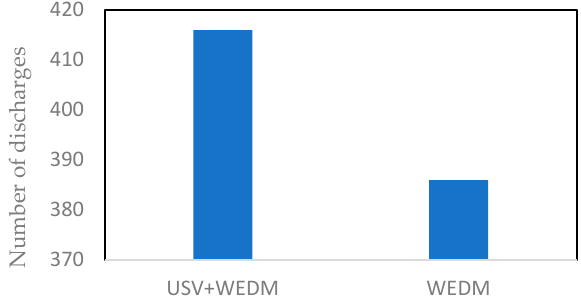
Figure 12 . Discharge waveform for ( a ) USV - WEDM and ( b ) WEDM .